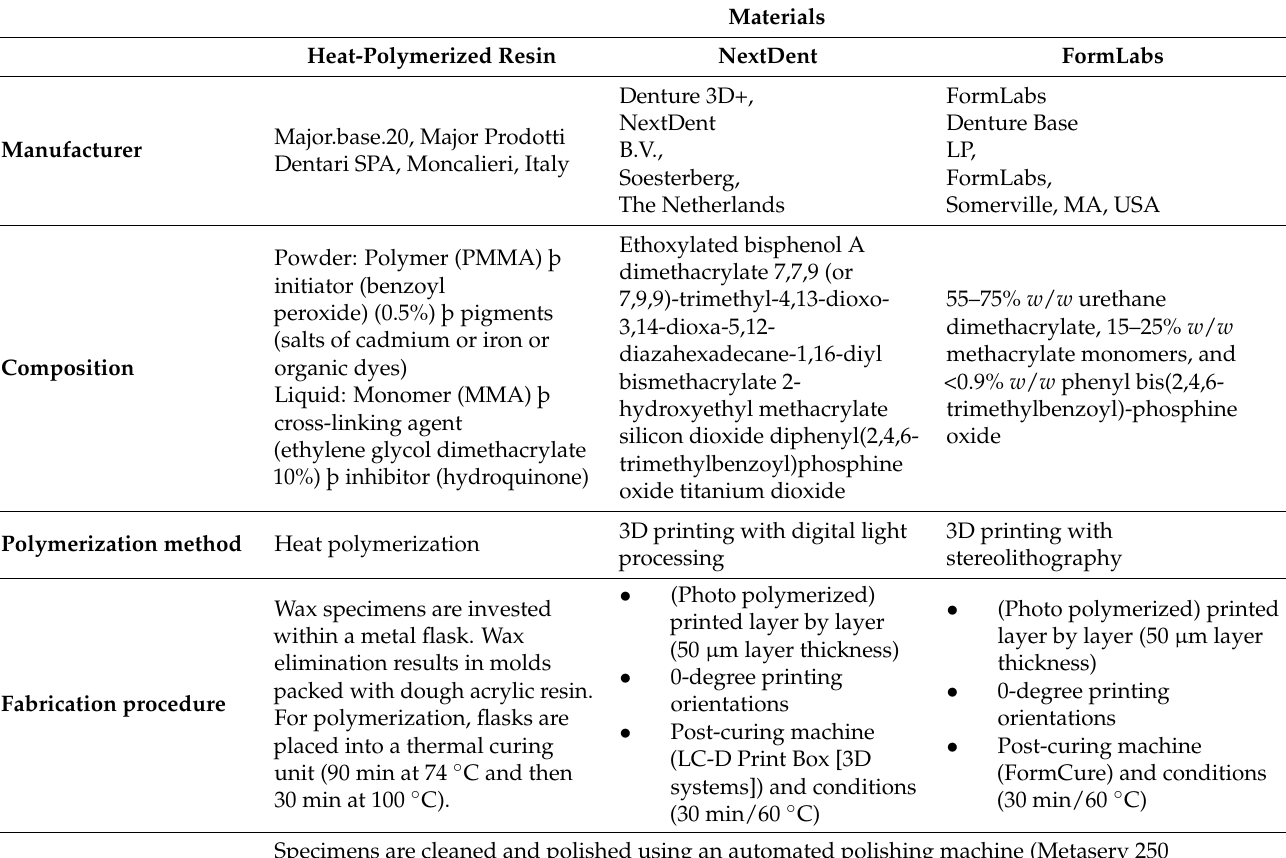
Table 1. Materials used for specimen fabrication and procedure